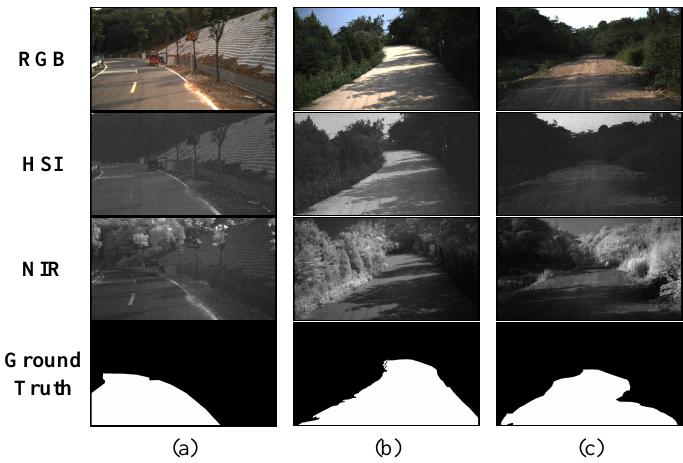
Figure 4. Example of multi-spectral images in HSI Road dataset [13]. ( a – c ) show three different scenes, and each scene includes three images that are from RGB, HSI, and NIR, respectively (from up to down). The images on the bottom represent the ground truth, which is annotated according to the RGB